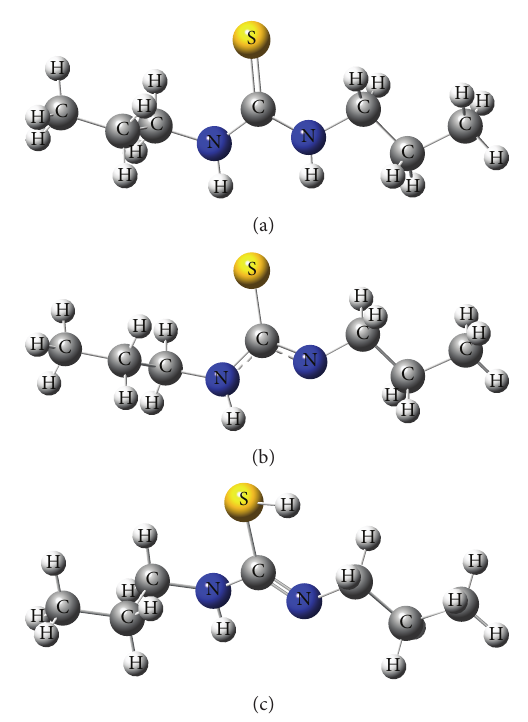
Figure 3: Optimized molecular model structures of PSTM-3T polymer before (a) and after treatment by pH = 5 (b) and pH = 2 (c) solutions. Carbon, hydrogen, nitrogen, and sulfur atoms are shown as gray, silver, blue, and yellow ball representations,